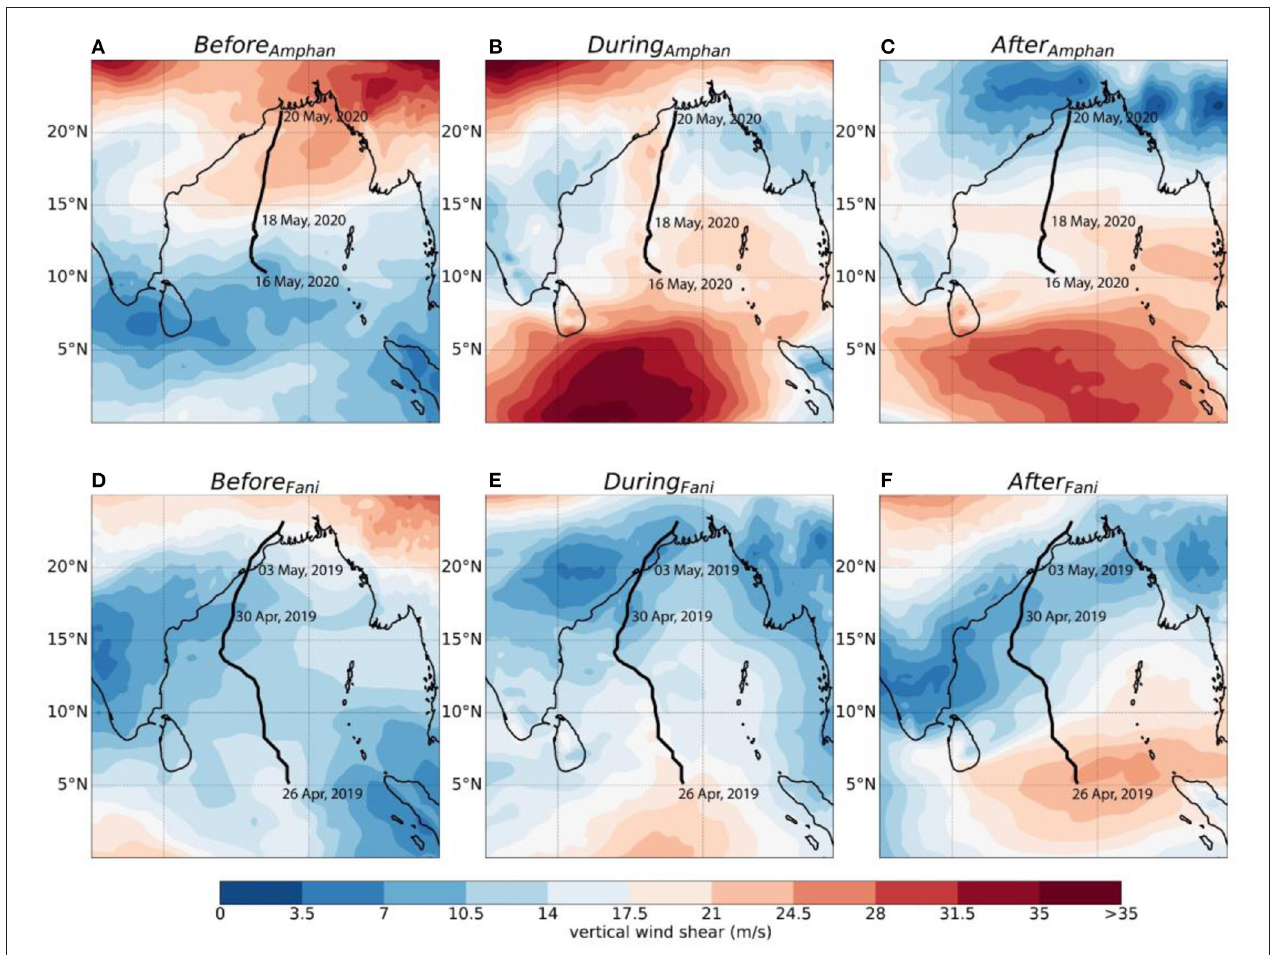
FIGURE 8 | Five days averaged vertical wind shear (m s − 1 ) (A) before Amphan (B) during Amphan (C) after Amphan. (D–F) same as (A–C) but for the cyclone fani. Dates in (A–C) representing cyclogenesis (16-May-2020), intensification (18-May-2020) and landfall (20-May-2020) during Amphan, and dates in (E-F) representing cyclogenesis (26-Apr-2019), intensification (30-Apr-2019), and landfall (3-May-2019) during